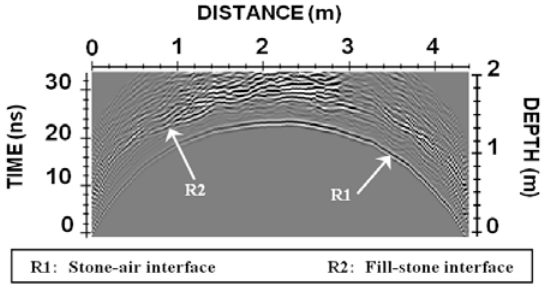
Figure 9. Processed radargram of first arch of Cernadela Bridge The integral model of the same vault of Cernadela bridge is shown in Fig. 10. In this figure, visible contours were accurately measured by photogrammetry and the profiles for arch thickness were estimated after processing the GPR data.